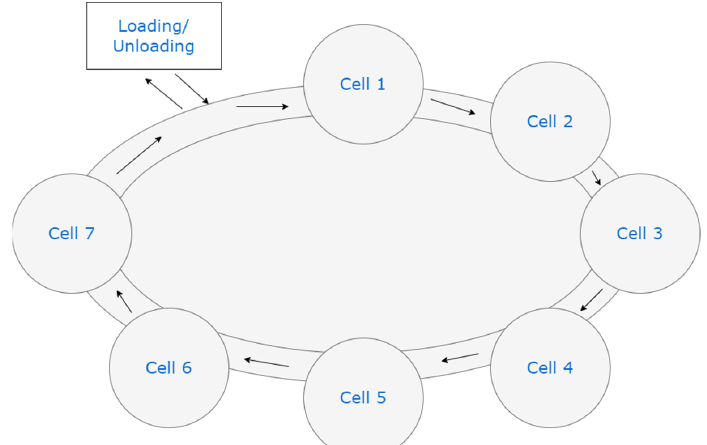
Fig. 1. Unidirectional loop Layout with 7 Machines with a Single Loading / Unloading